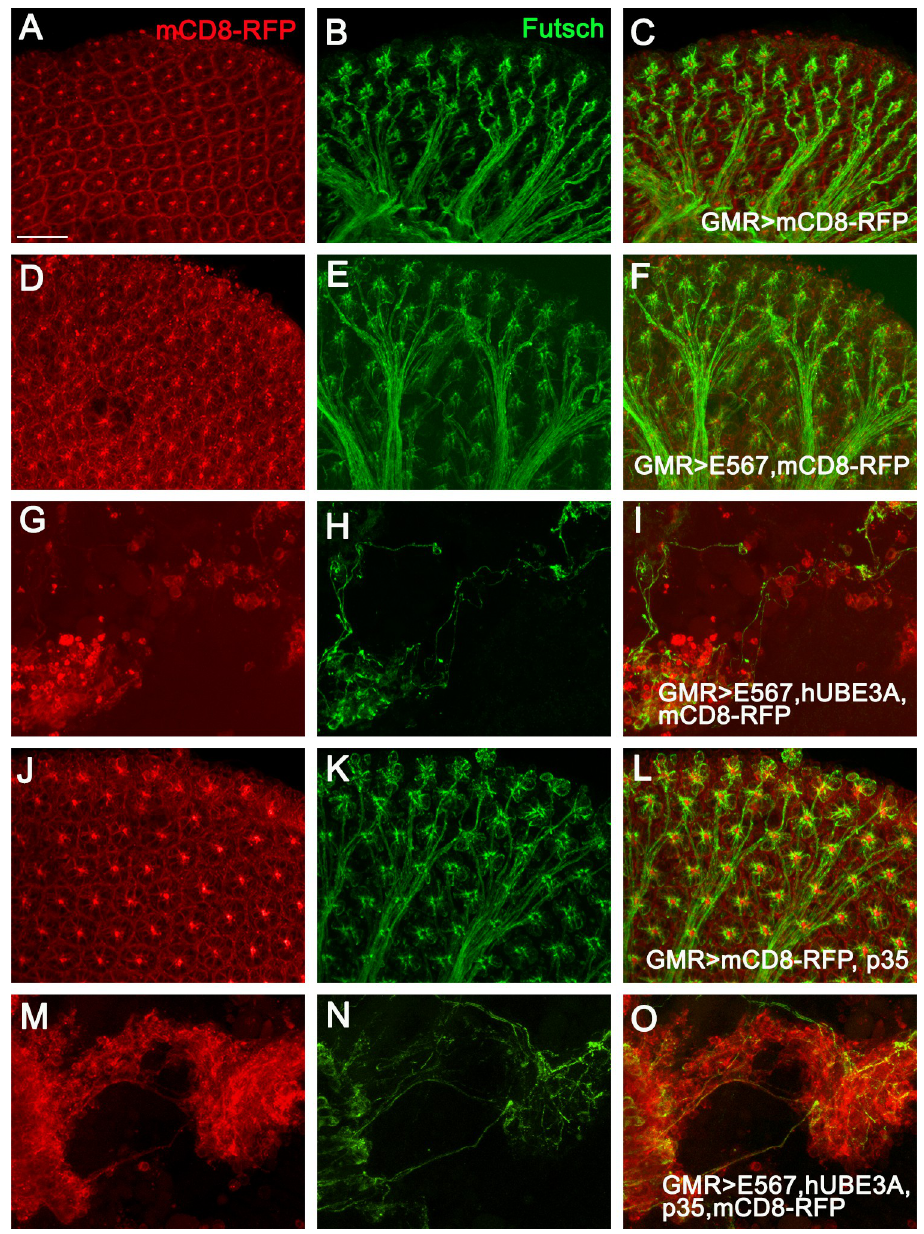
Fig 9. HPV16 oncogenes in cooperation with hUBE3A induce the transformation of epithelial cells to neuron-like cells. Transgenes were expressed in the epithelium of the eye tissues using GMR-Gal4. mCD8RFP was used to mark the cell membranes in the GMR-Gal4 expression region. All eyes are from 42 hours after pupation and immunolabeled for axonal marker, Futsch. (A-C) Pupal eye expressing mCD8RFP exhibited a stereotype pattern of hexagonal array of ommatidia (A) from which only the photoreceptor neurons of each ommatidia project axons that fasciculate together and project as a single bundle towards the optic lobes of the brain (B) . Co-expression of mCD8RFP+E5, E6, E7 (D-F) or co-expression of mCD8RFP+E5, E6, E7+p35 (J-L) had no effect on ommatidia differentiation and photoreceptor axonal projections. Pupal eyes co-expressing E5, E6, E7+hUBE3A+ mCD8RFP (G-I) or E5, E6, E7+hUBE3A + mCD8RFP+p35 (M-O) showed no differentiated ommatidia but instead clusters of cells (G, M) with rounded cell morphology and cellular protrusions that expressed the axonal marker Futsch (H, N) . The axon-like protrusions were developed by both the malignant cells and cells within the primary cluster (I, O) . Scale bar represents 100 μ m.